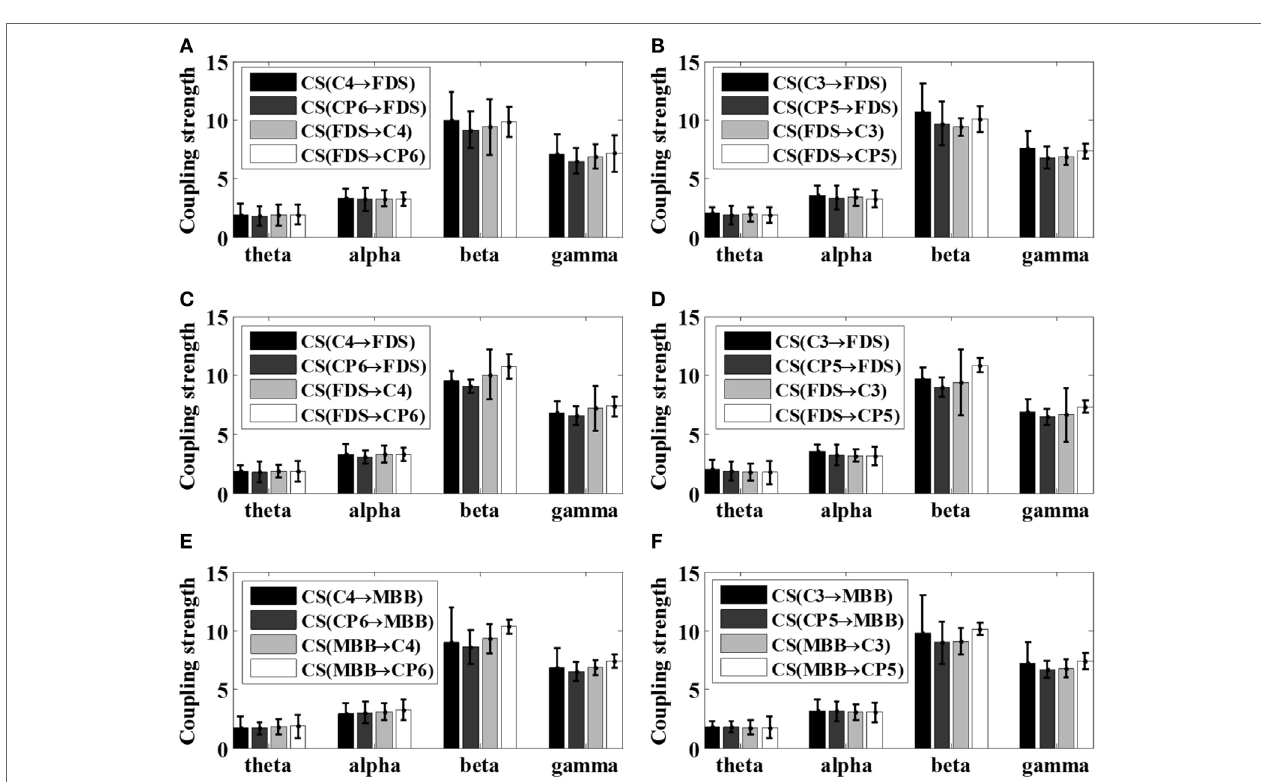
FigUre 6 | Summarized coupling strength (CS) of patient group (S1–S5) with respect to various motor tasks. (a) Left 5 kg; (B) right 5 kg; (c) left 10 kg; (D) right 10 kg; (e) left elbow flexion; (F) right elbow